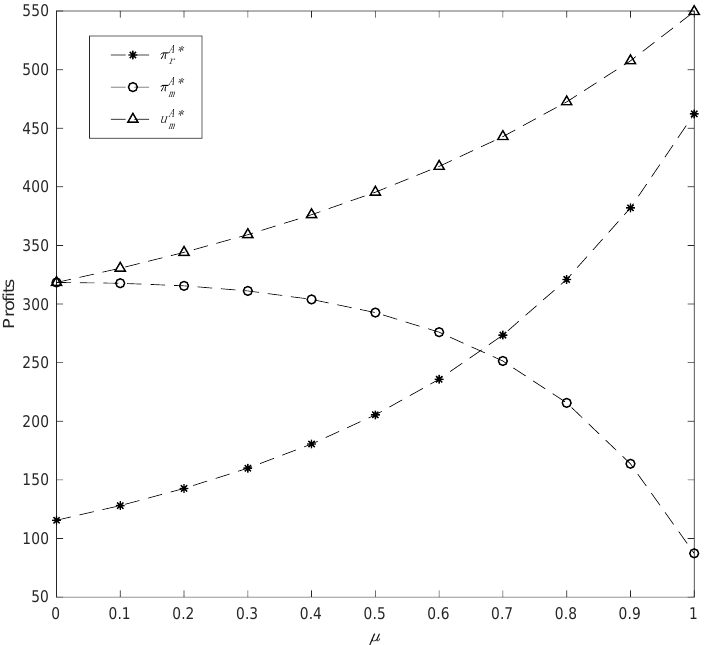
Figure 8. The change in profits with r parameter μ.